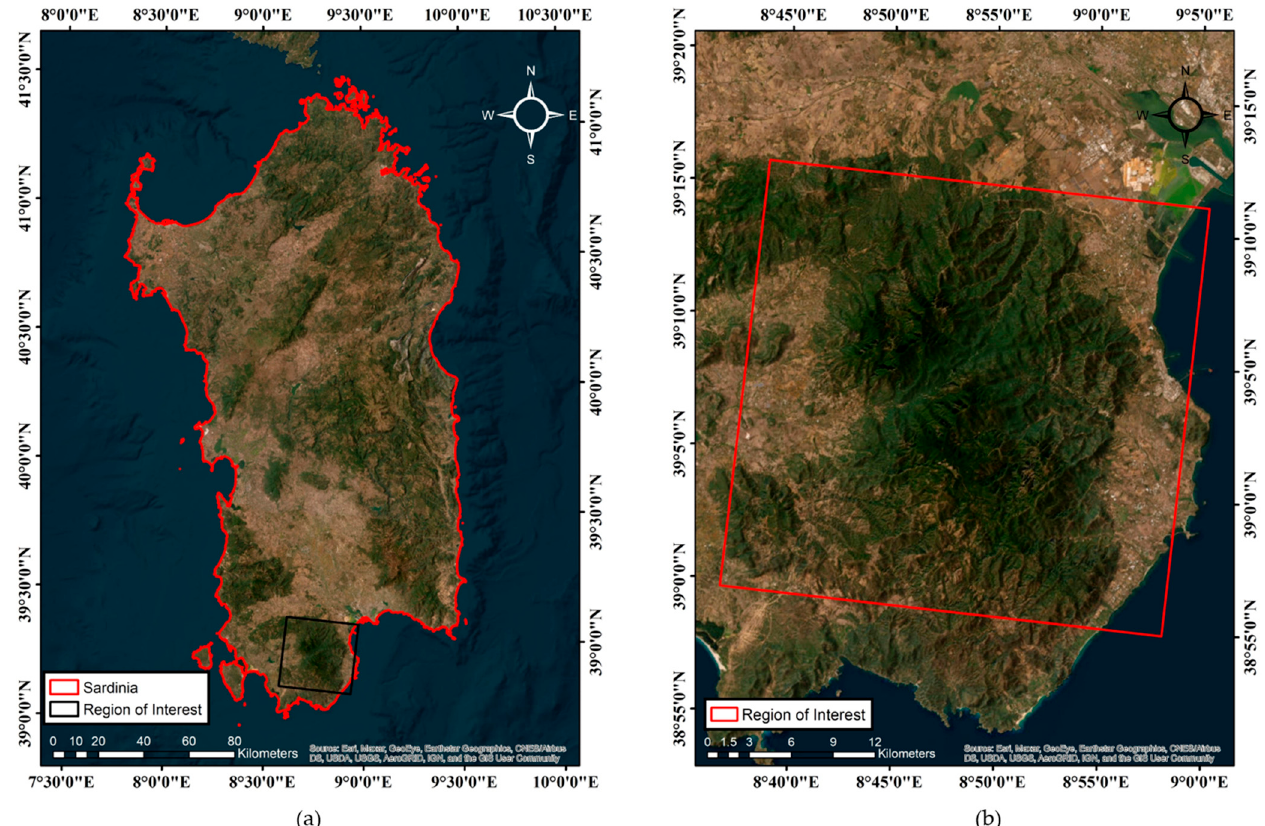
Figure 1. ( a ) Sardinia Island. ( b ) The region of interest is a forested area of 900 square km.